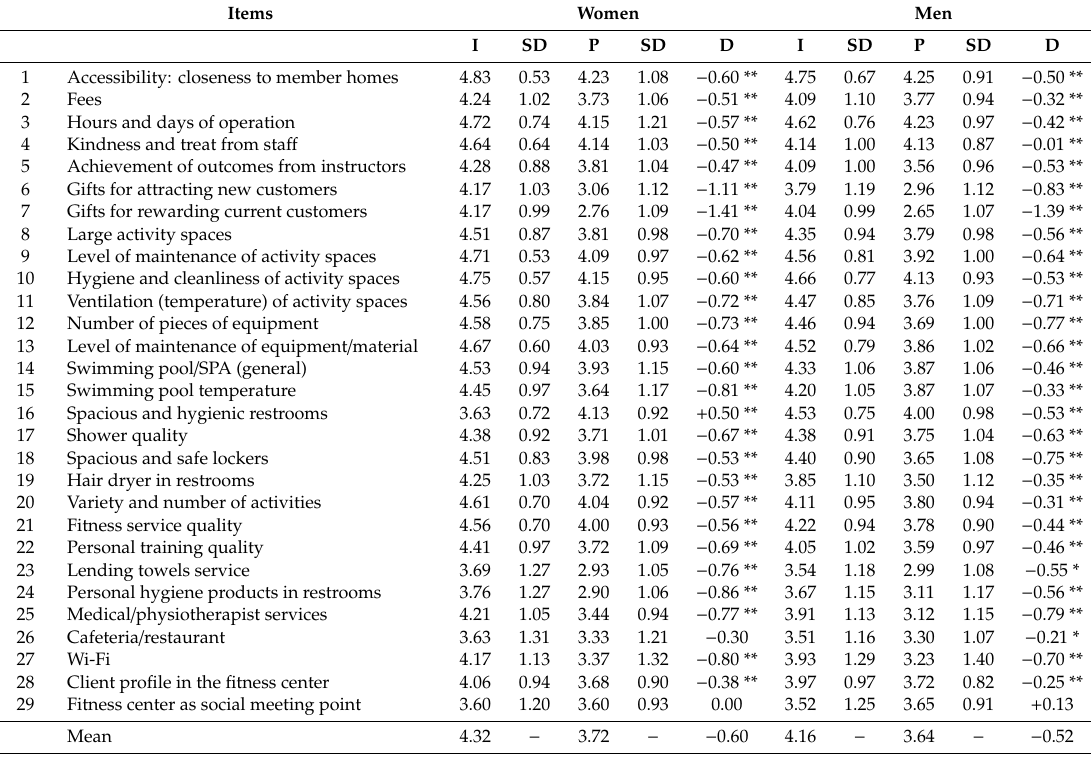
Table 2. IPA results according to